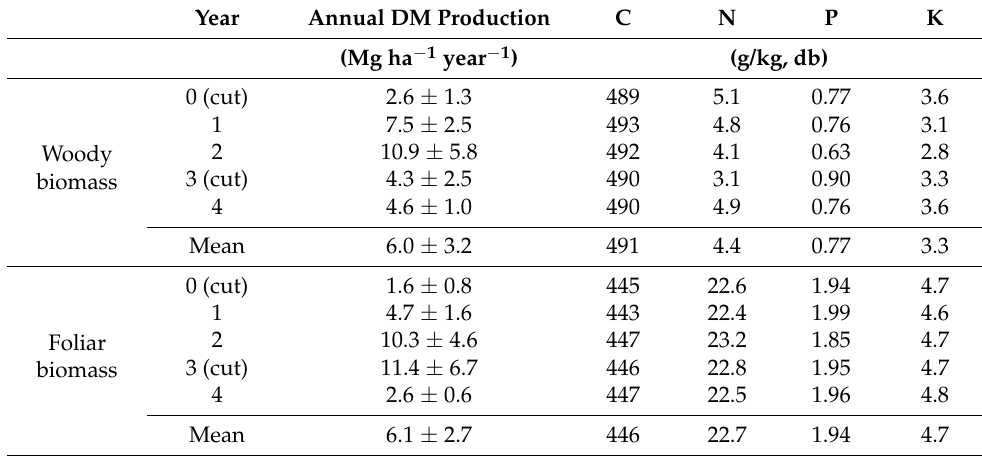
Table 3. Woody and foliar biomass annual production and